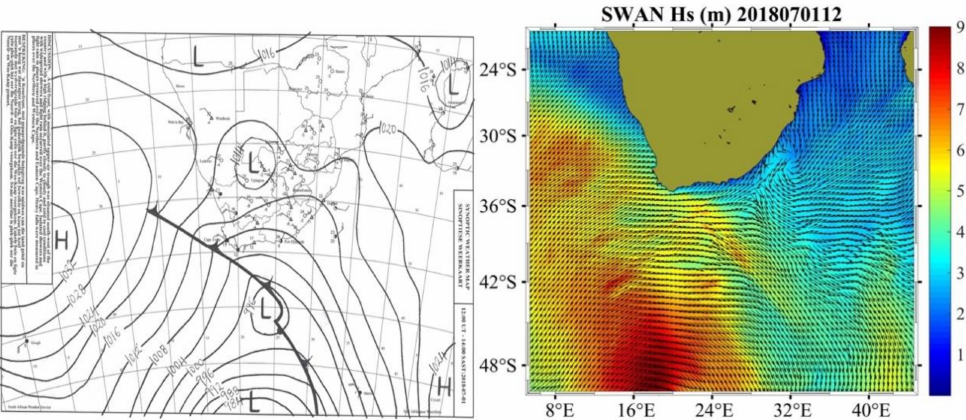
Figure 4. The synoptic map showing the weather conditions ( left ) for the 1 July 2018 at 12 UTC. Right image is the Simulating Waves Nearshore (SWAN)